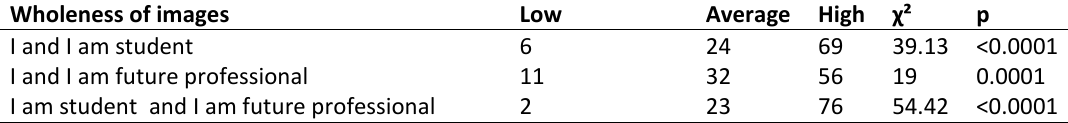
Table 2. Wholeness of personality’s images of future health basics teachers Wholeness of images